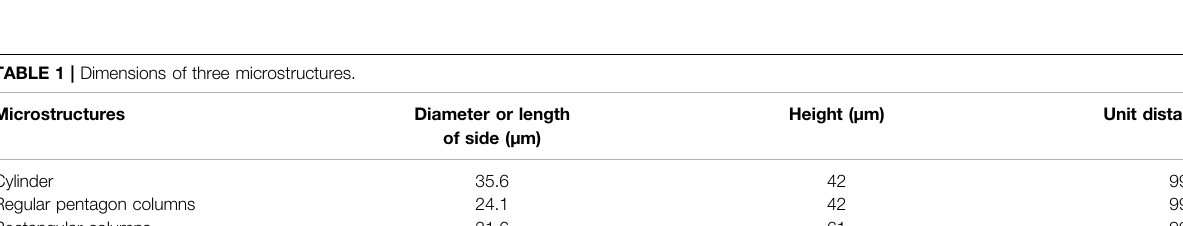
TABLE 1 | Dimensions of three microstructures.